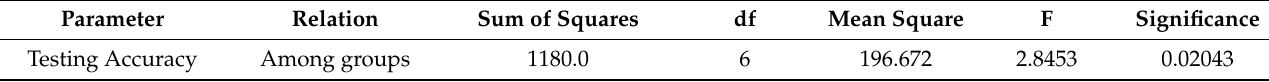
Figure 42. Classification Testing Accuracy Results. Table 12. One way ANOVA test results of DE variants.